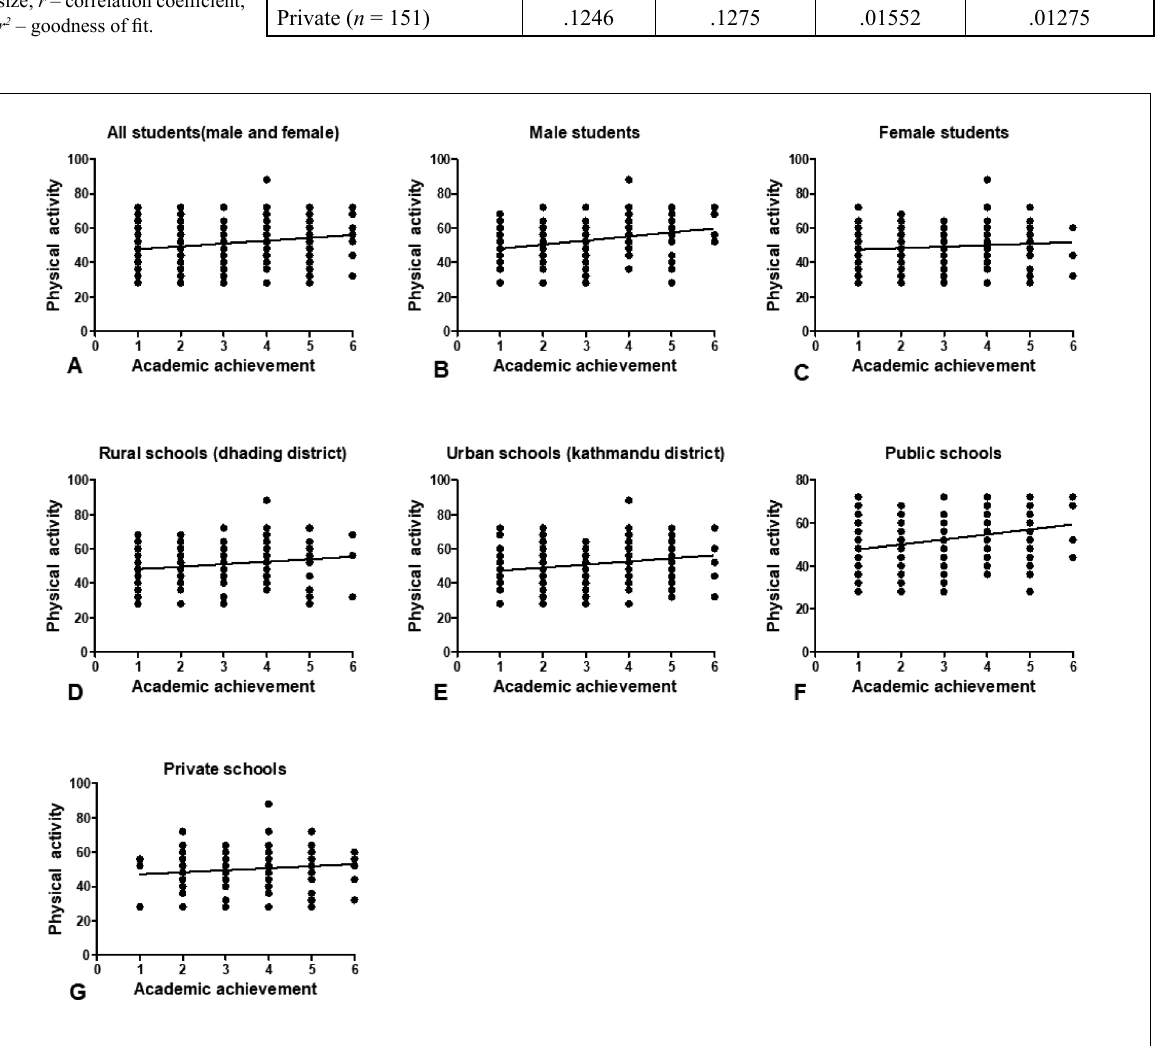
Figure 1. (A) Correlation between physical activity (PA) and academic performance (AP) in all school children; (B) male students; (C) female students; (D) rural school children; (E) urban school children; (F) public school; (G) private